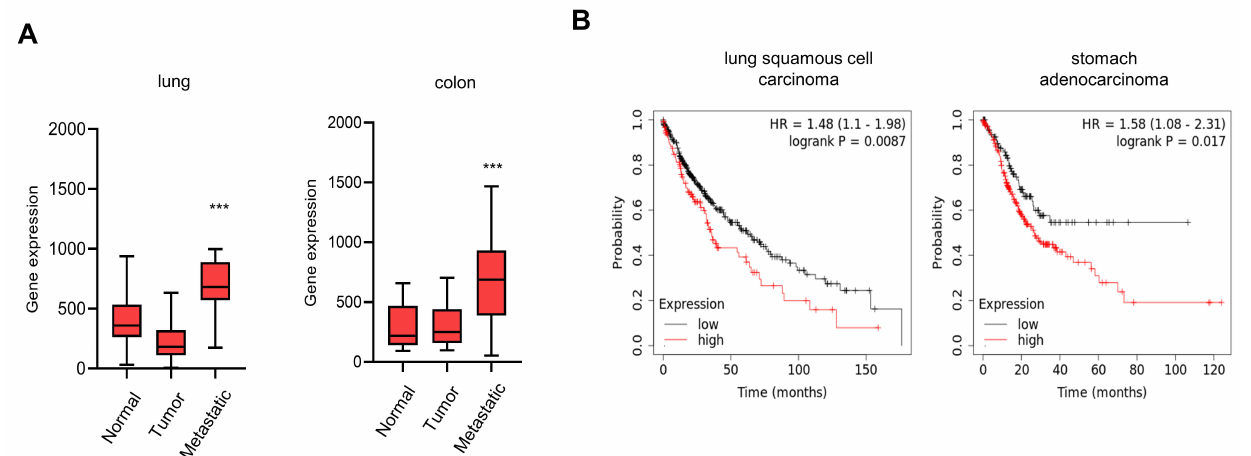
Figure 5. CTRP1 expression is associated with tumor progression. ( A ) mRNA expression of CTRP1 was upregulated in metastatic cancers. The mRNA expression of CTRP1 was analyzed in lung and colon cancers. Nonmetastatic (normal and tumor) vs. metastatic tumor: *** p < 0.005. ( B ) Elevated levels of CTRP1 are related with poor prognosis. The high expression of CTRP1 resulted in low survival rates in patients with lung squamous cell carcinoma and stomach